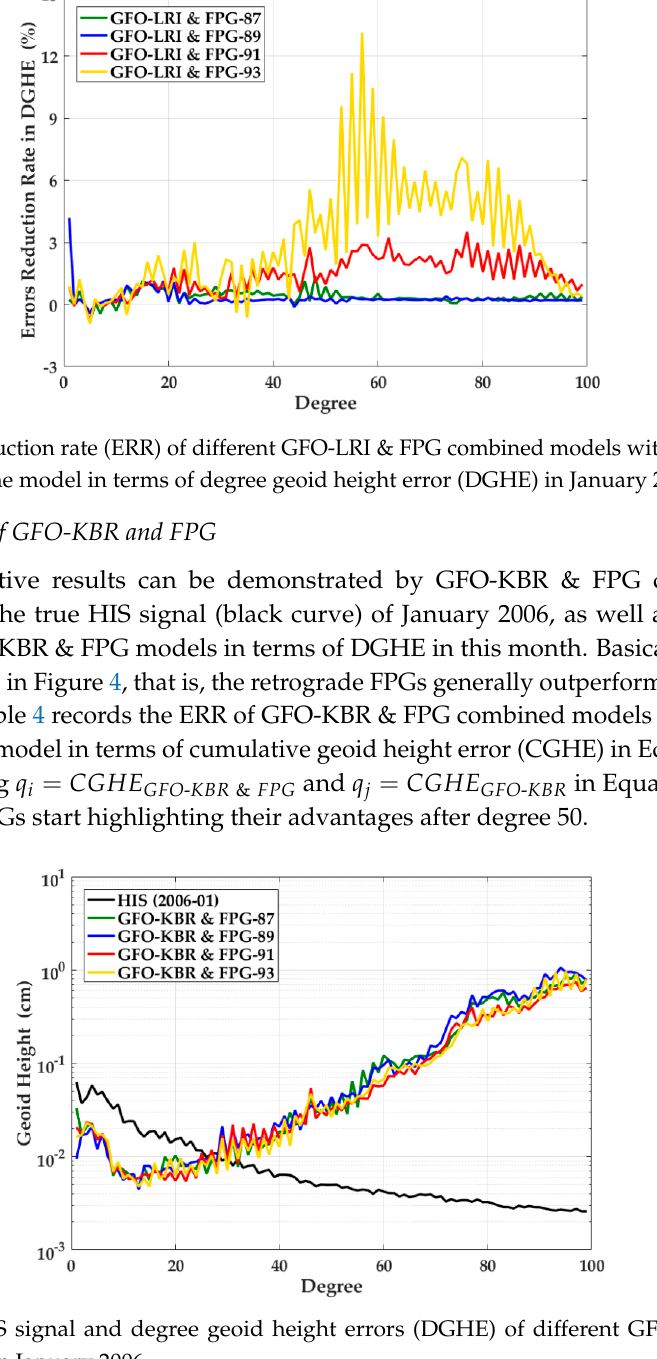
Figure 5. True HIS signal and degree geoid height errors (DGHE) of different GFO-KBR & FPG combined models in January 2006. Table 4. Error reduction rate (ERR) of different GFO-KBR & FPG combined models with respect to